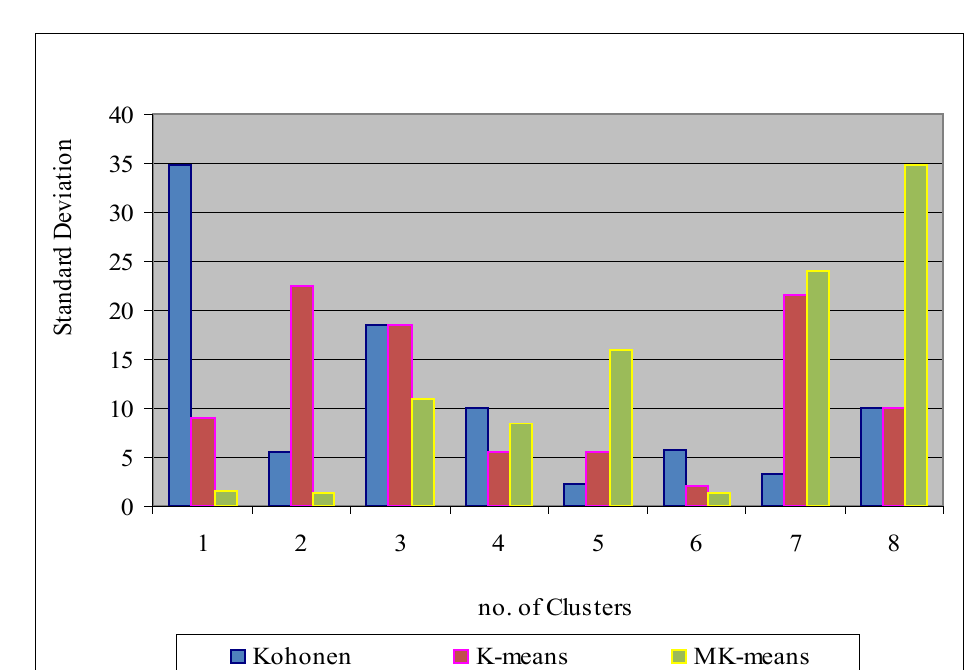
Figure 9. Difference between K-means, MK-means, and